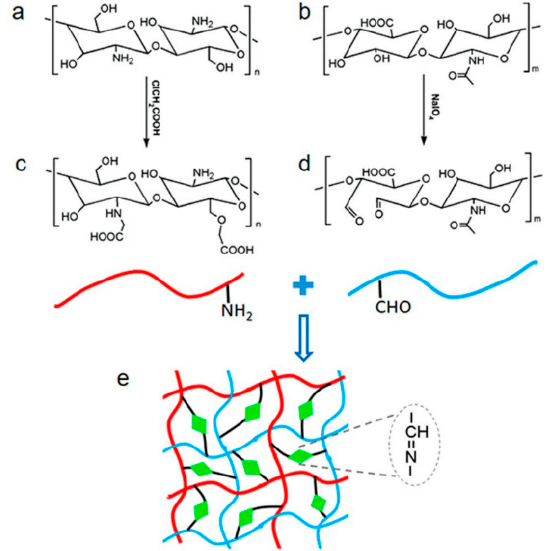
Figure 2. Schematic illustration of preparation of CS/HA hydrogel via Schiff’s base reaction. Chemical structures of chitosan (CS) ( a ), carboxymethyl chitosan (NOCC) ( c ), hyaluronic acid (HA) ( b ), and aldehyde hyaluronic acid (A-HA) ( d ). The employed fibrin gel or CS/HA hydrogel (green arrow: fibrin gel or CS/HA hydrogel ( e ). From [29].